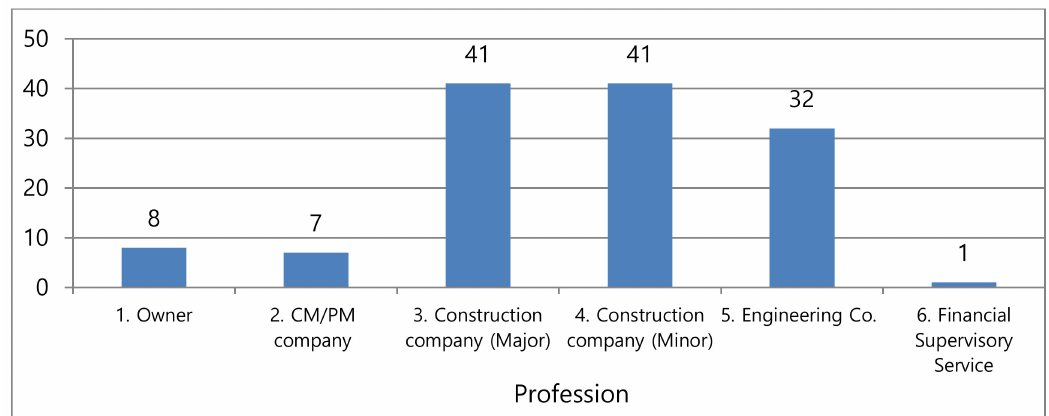
Figure 4. Department of the research targets.